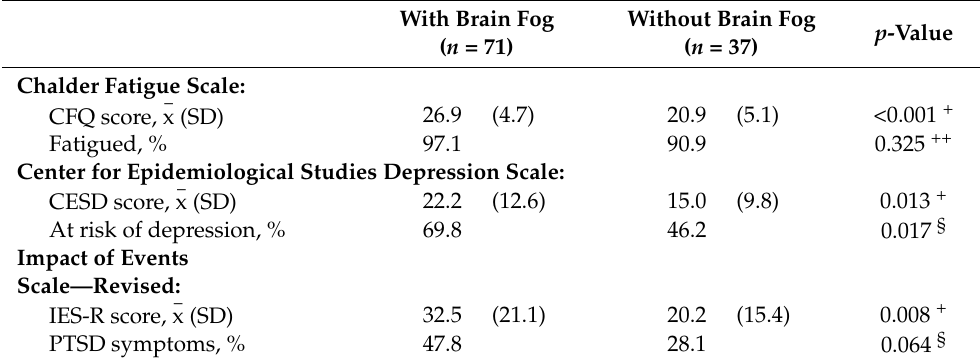
Table 3. Comparison of CFQ, CESD, and IES-R scales between participants with and without brain fog.